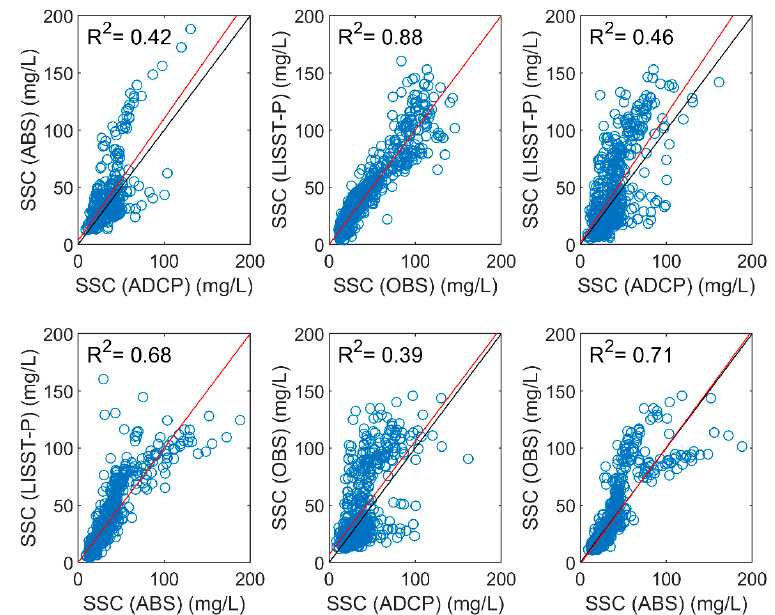
Figure 4. Results of comparison of indirect methods (the values of the Acoustic Doppler Current Profiler (ADCP) is calibrated by the sonar equation; the values of the LISST-ABS (Acoustical Backscatter Sensor) and VELP TB1 turbidimeter are calibrated by the equation of simple linear regression between them and the LISST-Portable | XR mass concentrations).